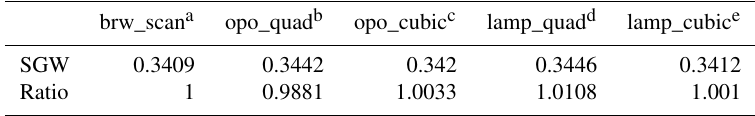
Figure 7. Differences between the central wavelengths (a) and FWHMs (b) determined directly and by the scanning methods, with the laser wavelengths in equally spaced grid every 5nm and lines of the discharge lamps. In both cases quadratic and cubic fits are used. Table 4. Ozone absorption coefficient, in atmcm − 1 , calculated using four absorption cross sections. brw_scan a opo_quad b opo_cubic